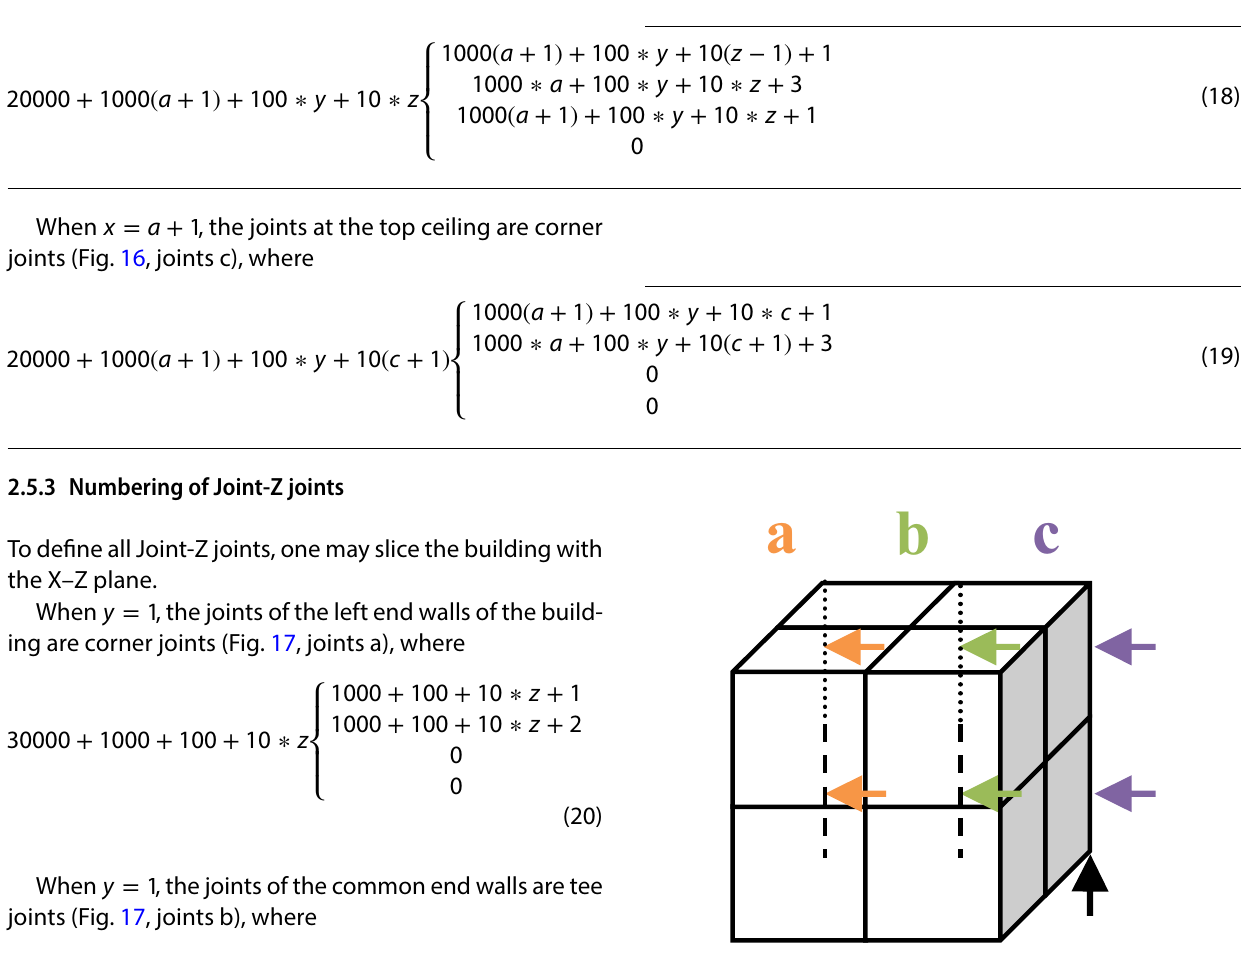
Fig. 17 Illustration of the Joint-Z joints when y = 1